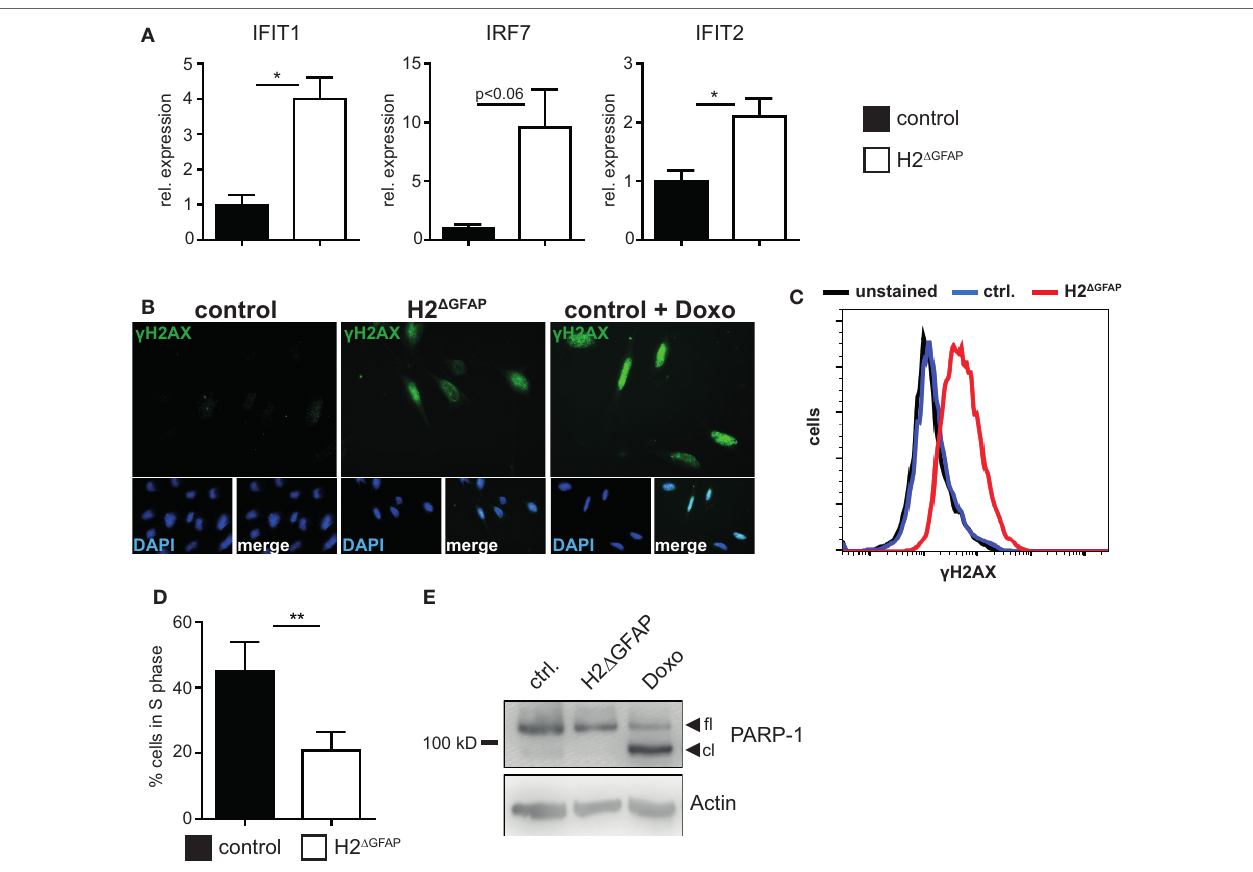
FigUre 4 | RNase H2 Δ GFAP astrocytes recapitulate features of Aicardi–Goutières syndrome patient cells. (a) Increased expression of selected interferon-stimulated genes (ISGs) in primary RNase H2 Δ GFAP astrocytes 7 days post isolation, as quantified by qPCR. ISG transcript levels in RNase H2 Δ GFAP astrocytes were normalized to GAPDH and indicated relative to control astrocytes ( x = 1). Error bars represent SEM, * p < 0.05, t -test ( n = 3). (B) Representative Immunofluorescence analysis ( n = 3) showing extensive DNA damage in RNase H2 Δ GFAP astrocytes 7 days post isolation, as evidenced by histone H2AX phosphorylation ( γ H2AX). Wild-type astrocytes treated with 1 µM Doxorubicin for 24 h served as positive control. DAPI as nuclear counterstain. (c) Representative flow cytometry histogram showing increased DNA damage in RNase H2 Δ GFAP astrocytes, compared to control astrocytes ( n = 3). Unstained cells were used as negative control. (D) EdU incorporation assay (4 h pulse) revealed significantly fewer RNase H2 Δ GFAP astrocytes in S-Phase 7 days post isolation. Error bars represent SEM, ** p < 0.01, t -test ( n = 4). (e) Immunoblot showing the absence of apoptosis in RNase H2 Δ GFAP astrocytes, as evidenced by lack of PARP-1 cleavage ( n = 2). PARP-1 is a caspase-3 substrate. Control astrocytes treated with 25 µM Doxorubicin for 24 h served as positive control, while β -Actin levels indicated equal loading. fl = full length, cl =